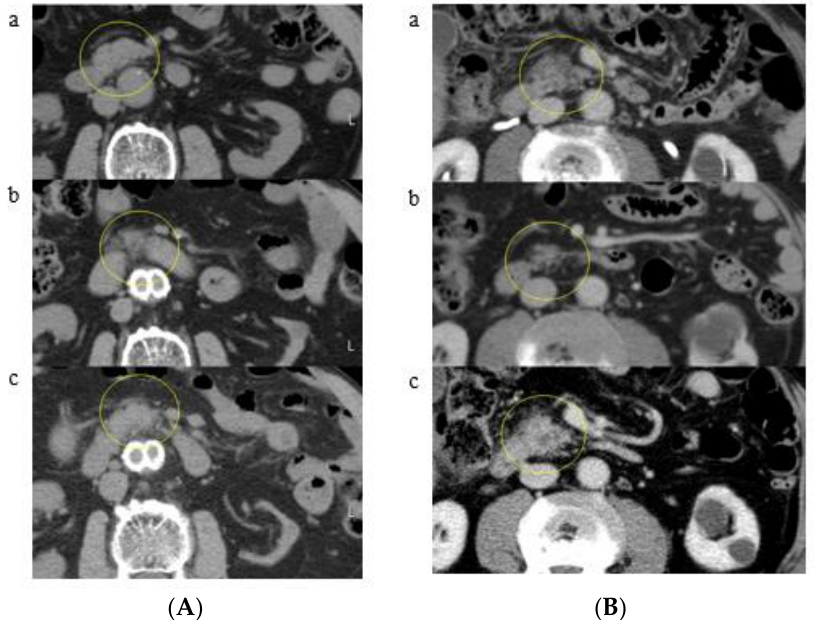
Cancers 2021 , 13 , x 7 of 11 yellow circle). ( B ) Group A (a representative patient with K-sign in the pancreatic head): ( a ) May 2004: pancreatic head looks normal on this CT (a yellow circle); ( b ) September 2012: K-sign is shown in the pancreatic head (a yellow arrow), ( c ) July 2013: pancreatic head cancer is developed at the site of K-sign (a yellow circle). ( C ) Group A (a representative patient with K-sign in the pancreatic tail): ( a ) October 2007: K-sign is shown in the pancreatic tail (a yellow circle); ( b ) October 2011: K-sign expanded compared with the previous CT in 2007 (a yellow circle); ( c ) August 2012: pancreatic tail cancer with main pancreatic duct dilatation is shown (a yellow circle). ( D ) Group A (a representative patient with K- sign and patented main pancreatic duct): ( a ) March 2003: pancreatic body looks normal on this CT (a yellow circle); ( b ) August 2011: K-sign (a yellow arrow) and main pancreatic duct (a yellow triangle) are shown; ( c ) August 2013: pan- creatic body cancer is shown at the site of K-sign (a yellow circle).